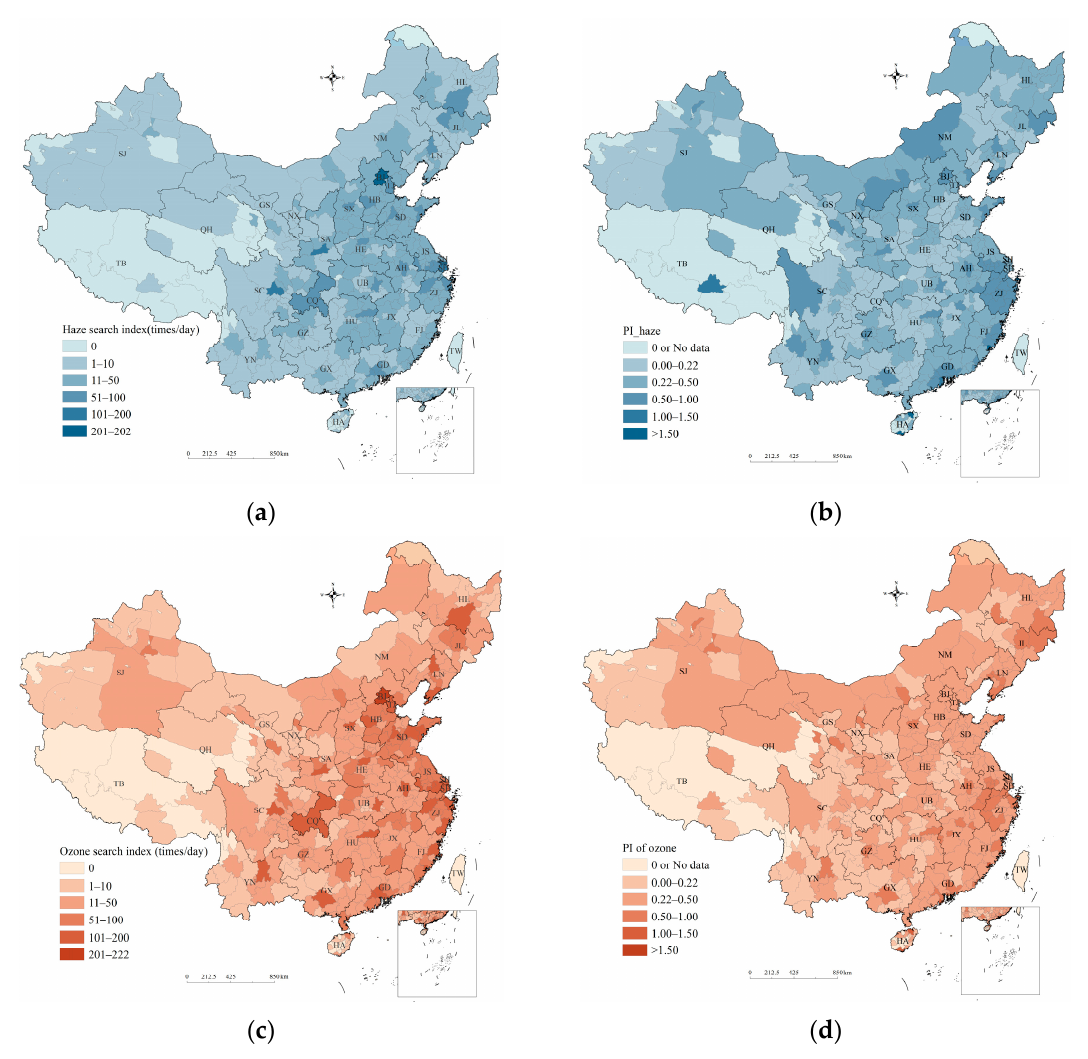
Figure 2. Search index and PI of haze and ozone in China: ( a ) haze search index; ( b ) PI haze ; ( c ) ozone search index; ( d ) PI ozone .